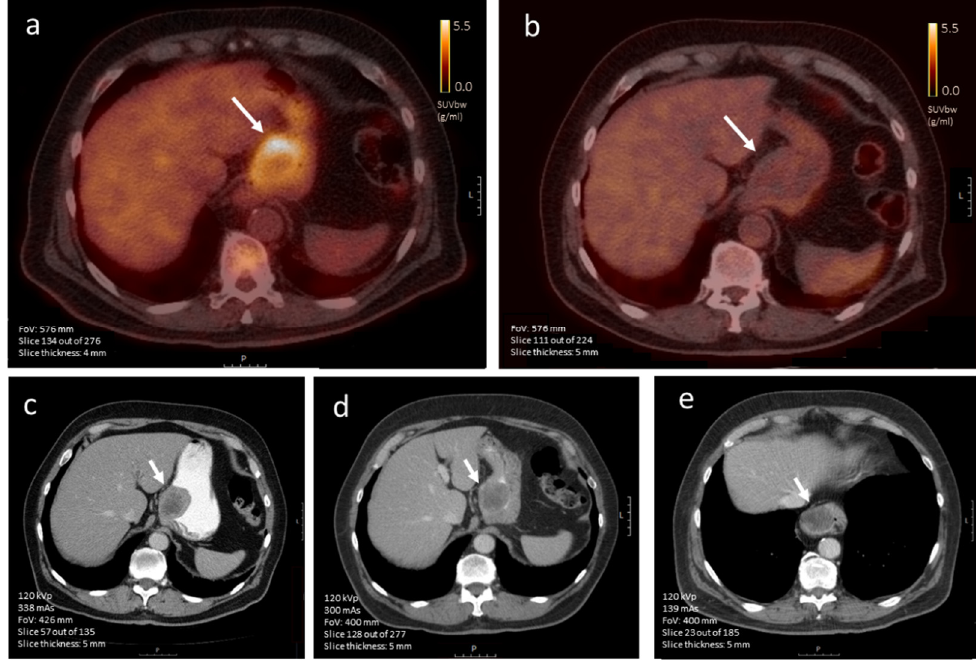
Figure 7. ( a – e ). Axial [18F]FDG-PET images of a 71-year-old male diagnosed with a primary gastric GIST ( a ) before treatment induction and ( b ) after about three months of TKI treatment, where the standardized uptake value (SUV) is normalized (scale bar 5 cm). Corresponding contrast-enhanced CT imaging (iodinated contrast media) visualizing the same lesion (arrow) ( c ) at diagnosis and after ( d ) 2.5 months and ( e ) 6.5 months of imatinib treatment, showing minimal to no change in tumor size (scale bar 5 cm). In the last image, the intrathoracic tumor location is caused by a sliding hernia.